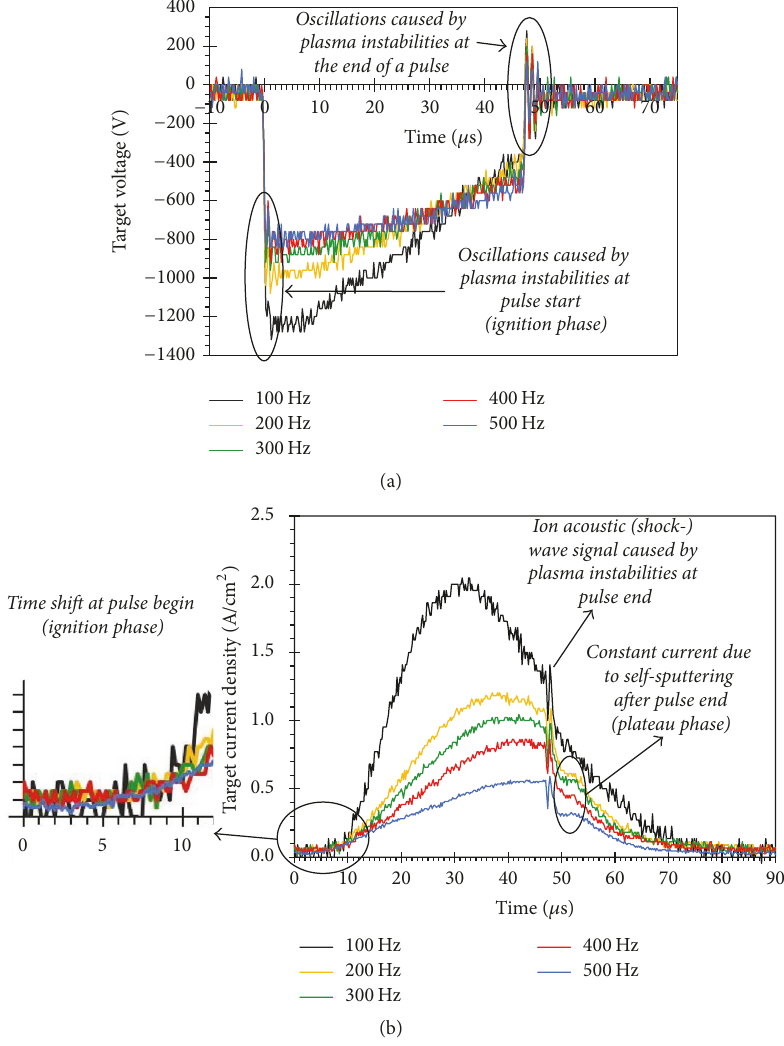
Figure 2: Time-dependent target voltages curves (a) and time-dependent current density per cm 2 target surface (b) for different frequencies in the range of 100–500 Hz measured during HPPMS discharge at a constant pulse length of 50 𝜇 s and mean power of 4 kW at 0.6